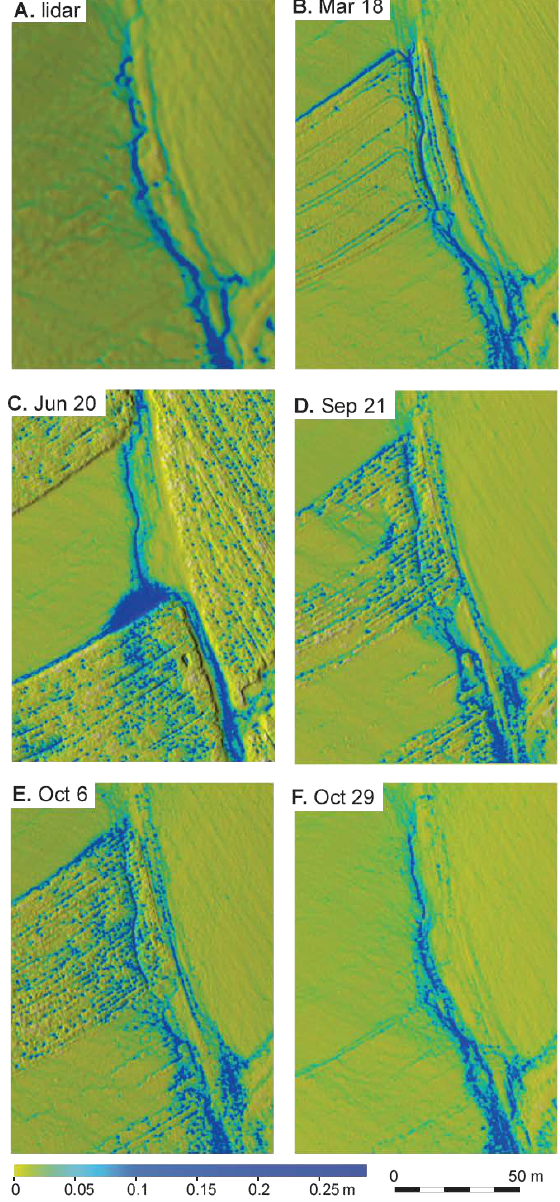
Figure 5: Areas of a special importance, enlarged on figures 6, 7, 8, and 9 Figure 6: Enlarged area A from Figure 5, with the visible gully The mean differences between DSMs derived from aUAS surveys ranged from − 0 . 1 cm in March to 36 . 6 cm in June (Table 2) and RMSE ranges from 1 . 3 cm in March to 39 . 2 cm in June and the spatial distribution of differences varies between the